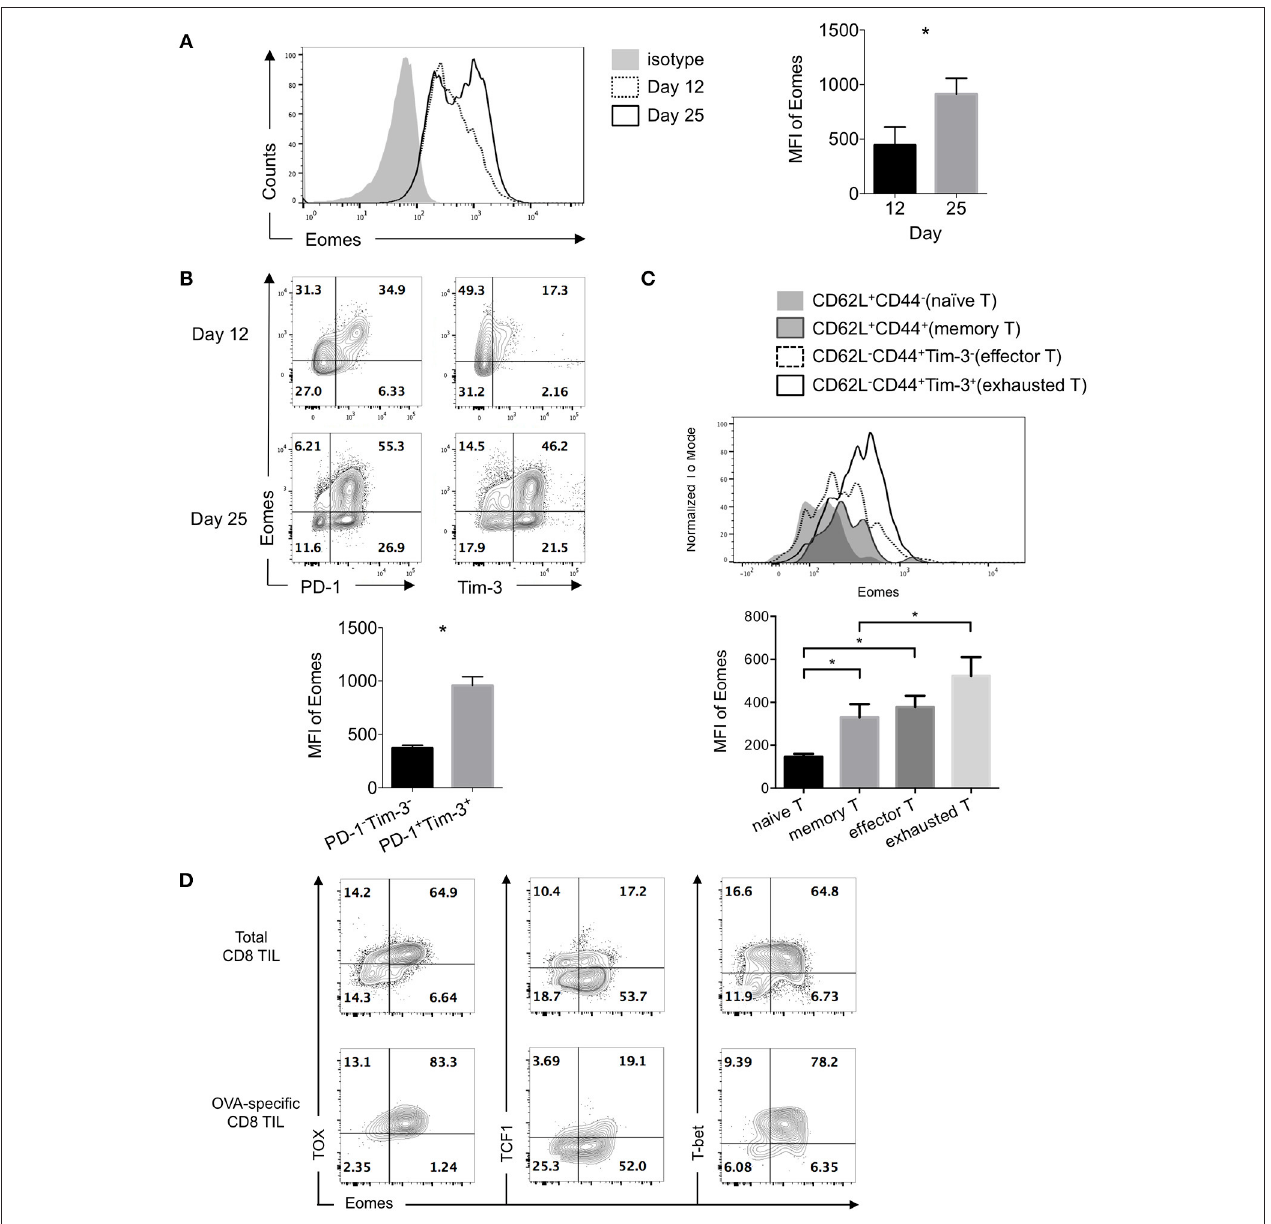
FIGURE 1 | Exhausted CD8 + TILs express elevated Eomes. 10 6 E.G7 cells were subcutaneously inoculated into C57BL/6 mice on Day 0. Tumor was harvested on Day 12 or Day 25 and TILs were isolated for flow cytometric analysis. (A) Representative (left) and summarized (right) histograms showing expression of Eomes in CD8 + TILs on Day 12 and Day 25 post tumor inoculation measured by intracellular flow cytometry. (B) Representative flow cytometric analysis of co-expression of Eomes with PD-1 or Tim-3 in CD8 + TILs on Day 12 and Day 25 (left) and summary histogram of expression of Eomes in PD-1 − Tim-3 − and PD-1 + Tim-3 + CD8 + TILs on Day 25 post tumor inoculation. (C) Expression of Eomes in CD8 + TILs at different differentiation stages. (D) Representative flow cytometric analysis of co-expression patterns of Eomes with TOX, TCF1 or T-bet in total CD8 + TILs and OVA-specific CD8 + TILs on Day 25 post tumor inoculation. Data are pooled from 2 independent experiments with 3–5 mice per group. Error bars denote mean ± SEM. Statistical analysis was performed using unpaired (A) and paired (B) Student’s t -test and ordinary One-way ANOVA analysis followed by multiple comparisons (C) * p < 0.05.